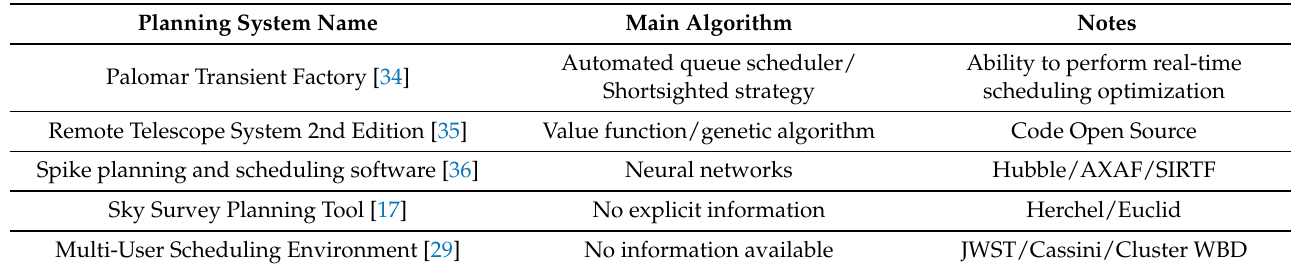
Table 2. Several widely used planning